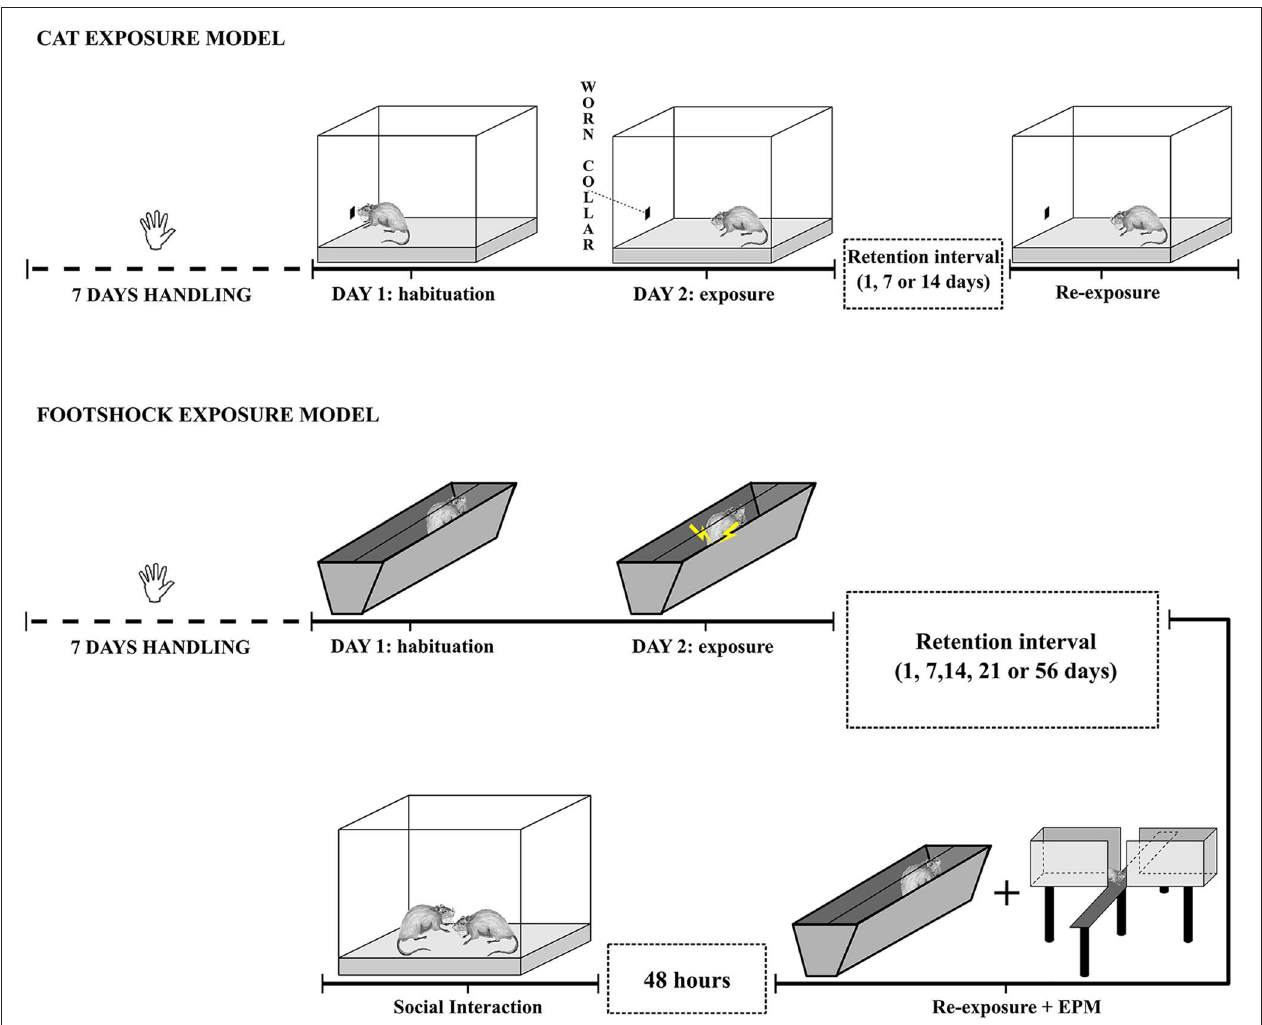
FIGURE 1 | Schematic representation of the cat odor and footshock exposure PTSD models